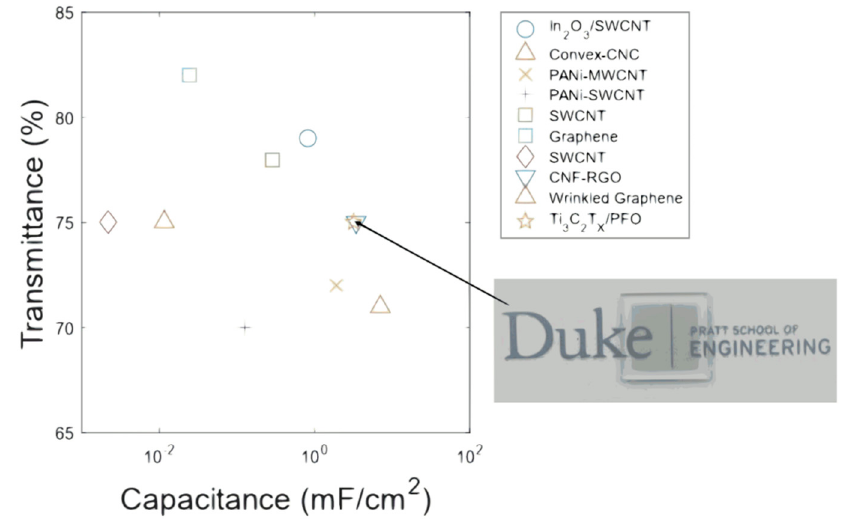
Figure3. Comparisonofarealcapacitancesforvariousmaterialsystemsreportedintheliterature[30–38]. Inset: picture of P15M85 film on a 1 cm x 1 cm glass substrate, indicating its high transparency.